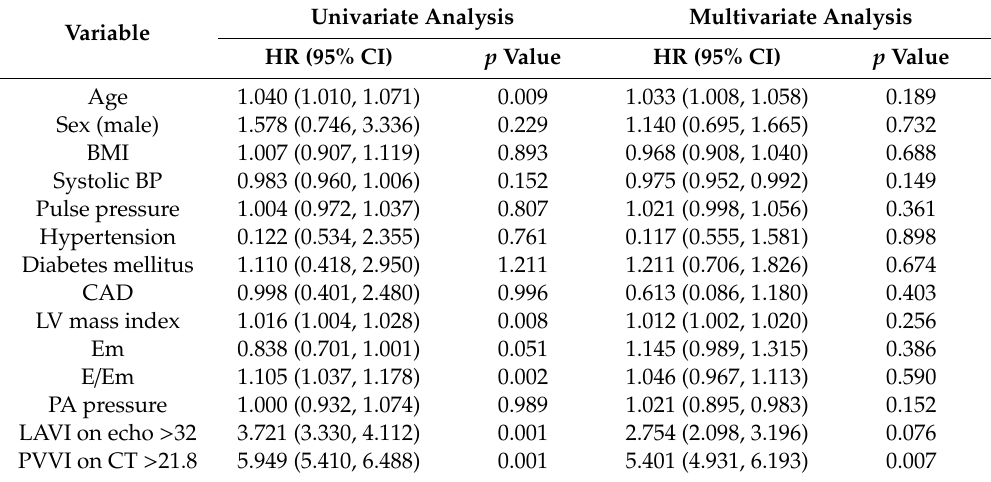
Table 3. Cox regression analysis for predicting new-onset atrial